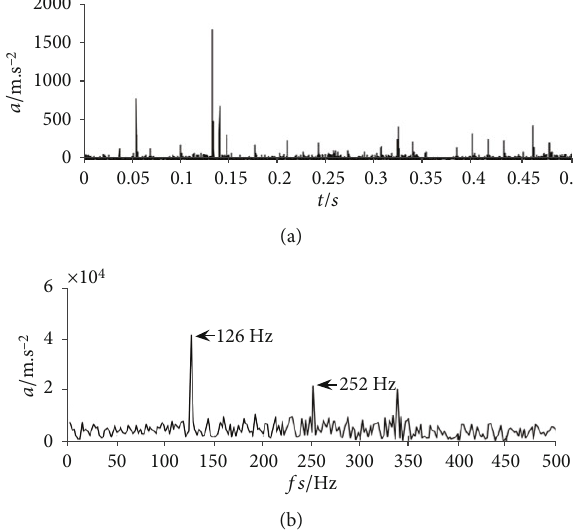
Figure 13: Waveform and frequency spectrum of bearing R an outer ring defect signal denoised by ISKF. (a) Waveform. (b) Frequency